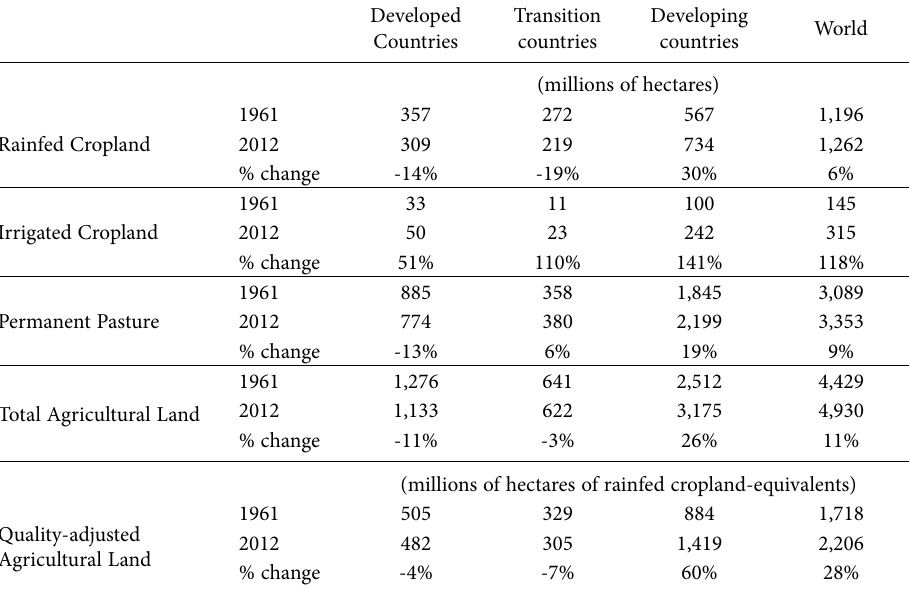
Table 2. Global Agricultural Land Use Changes Between 1961 and 2012 (millions of